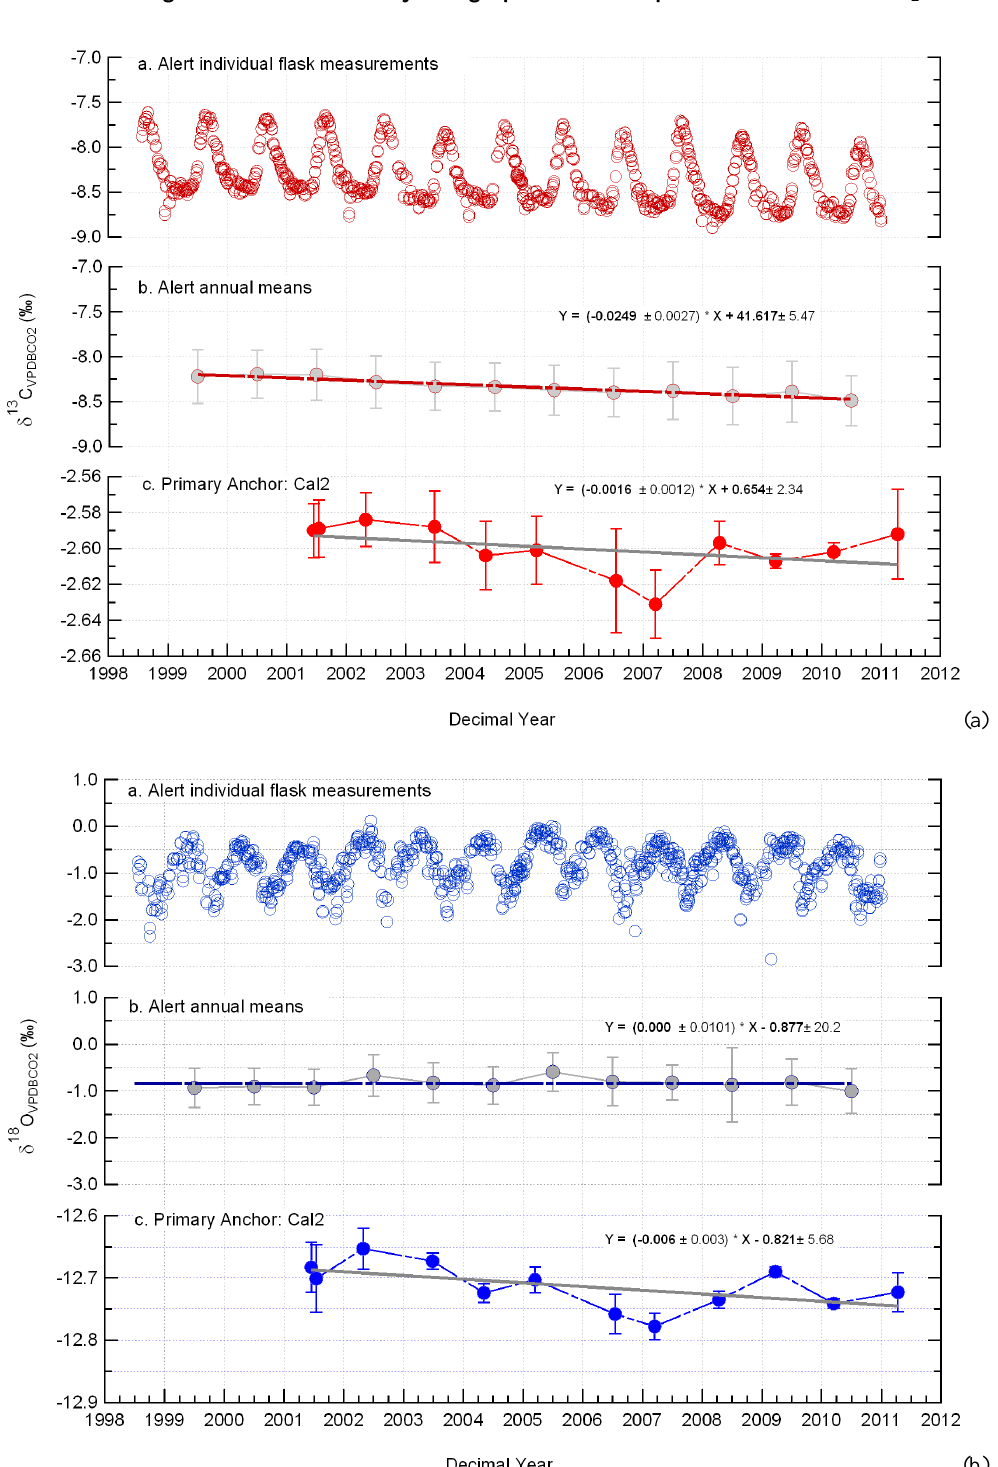
Fig. 1. (a) Evaluating the trend in δ 13 C measurements of flask CO 2 at Alert (1998–2010) with the trend of the primary anchor. The top panel a: the individual flask measurements of δ 13 C at Alert from 1998 to 2010 by Environment Canada; the middle panel b: the annual means of flask measurements in δ 13 C from 1998 to 2010 (the range of “X” in the linear relationship: > 1999 and < 2011); the bottom panel c: the calibration results of the primary anchor (Cal2) in δ 13 C from 2001 to 2011(the range of “X” in the linear relationship: > 2001 and < 2012). (b) Evaluating the trend in δ 18 O measurements of flask CO 2 at Alert (1998–2010) with the trend of the primary anchor. The top panel a: the individual flask measurements of δ 18 O at Alert from 1998 to 2010 by Environment Canada; the middle panel b: the annual means of flask measurements in δ 18 O from 1998 to 2010 (the range of “X” in the linear relationship: > 1999 and < 2011); the bottom panel c: the calibration results of the primary anchor (Cal2) in δ 18 O from 2001 to 2011 (the range of “X” in the linear relationship: > 2001 and <